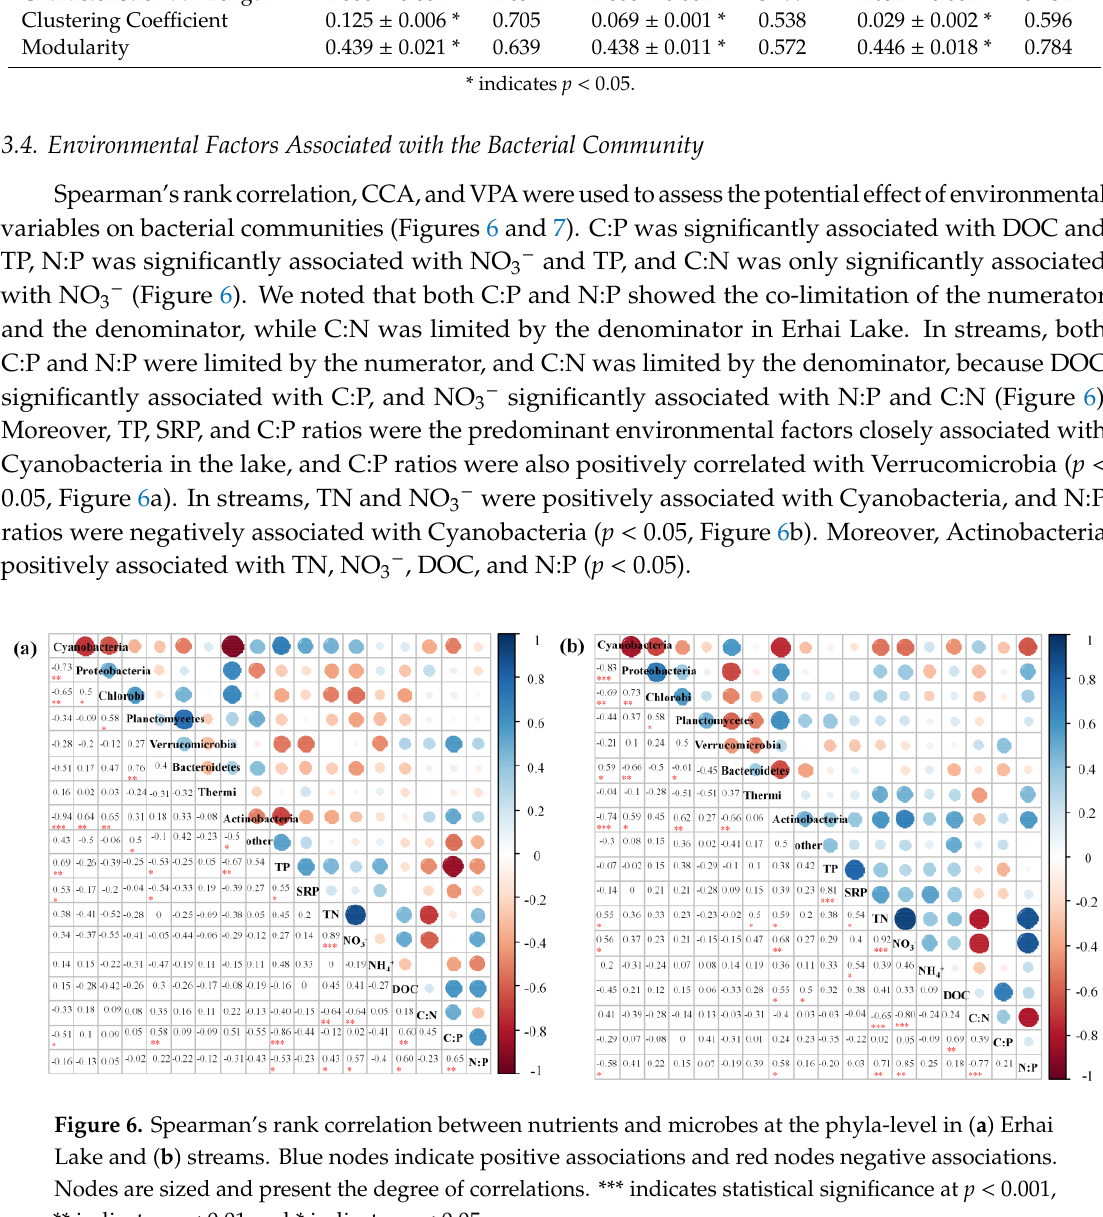
Figure 7. Canonical correspondence analysis (CCA) of bacterial communities and nutrient variables in Erhai Lake ( a, c, and e ) and streams ( b, d, and f ). All environmental variables had goodness of fit